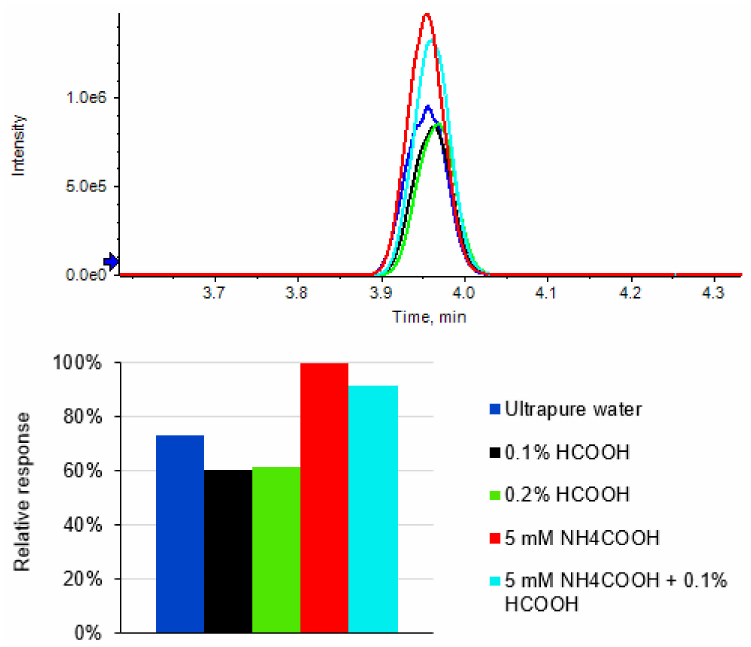
Figure 2. Effects of different LC aqueous phases on peak shape and response of